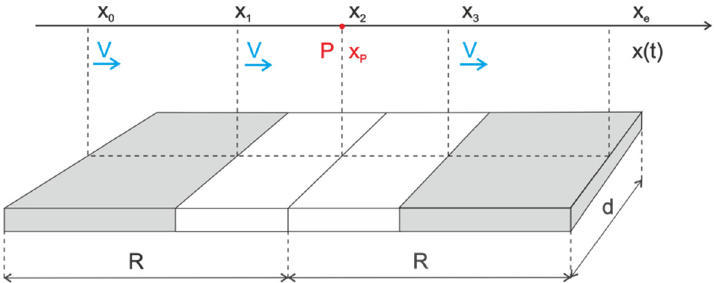
Figure 3. The schematic profile and geometry of longwall mining for the case of a full deformation profile at point 𝑃 (own study), (V- velocity of exploitation).